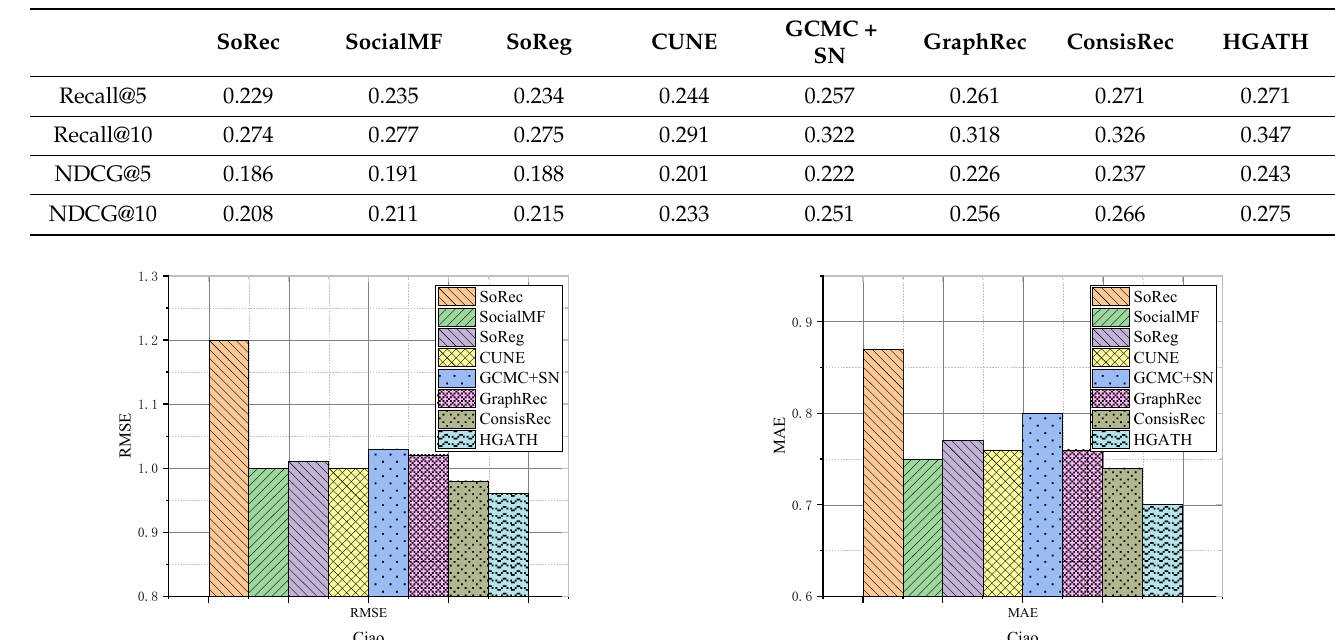
Table 5. Comparisons of different methods on the Ciao dataset.